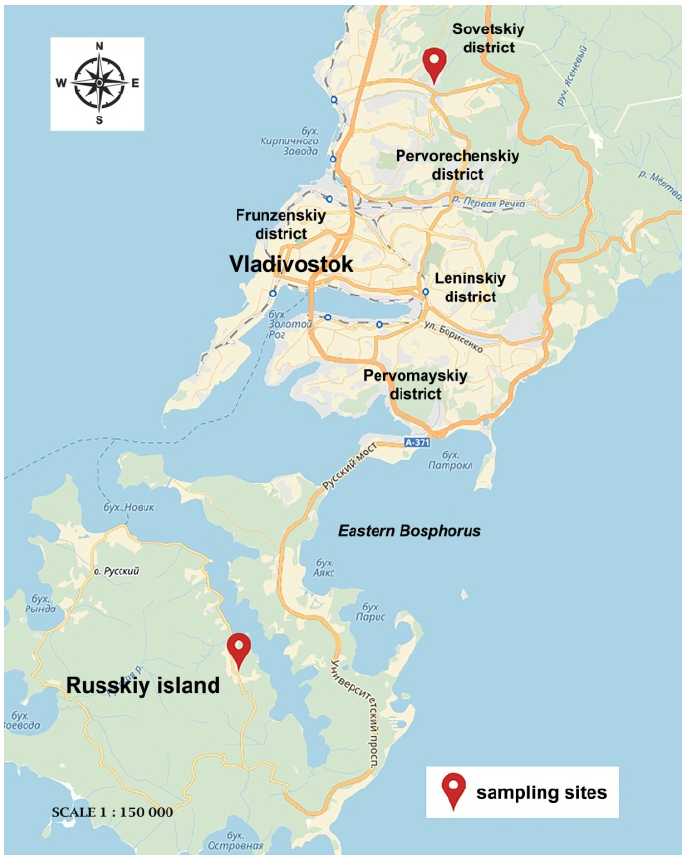
Figure 1. Location of the sampling sites of the atmospheric surface layer in two districts of Vladivostok with different levels of technogenic pollution.